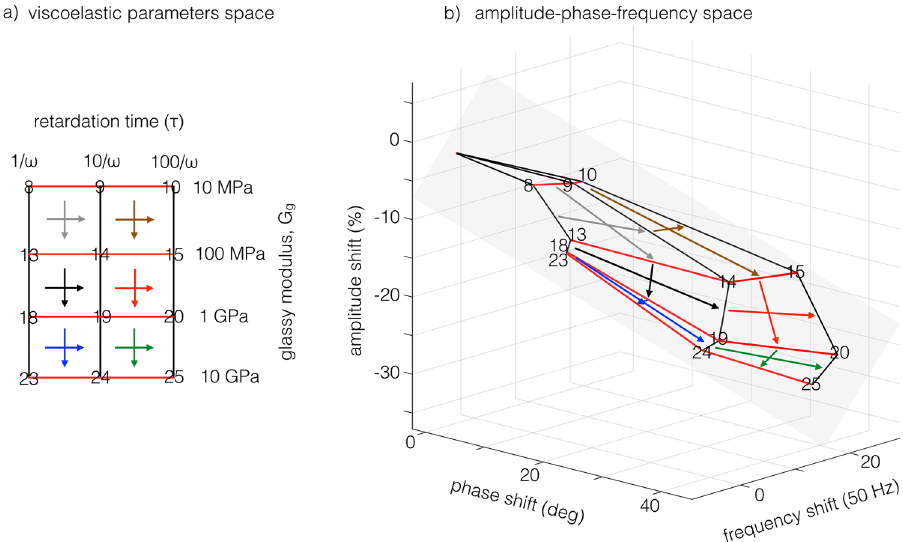
Figure 7. ( a ) Viscoelastic parameters space, in the form of a square grid with numbered vertices and equal logarithmic increments of the parameters. ( b ) amplitude-frequency-phase space representing the same grid as in a). Note the deformation caused by the transformation to the new coordinates and the preservation of the topology, a characteristic of transformations that behave as